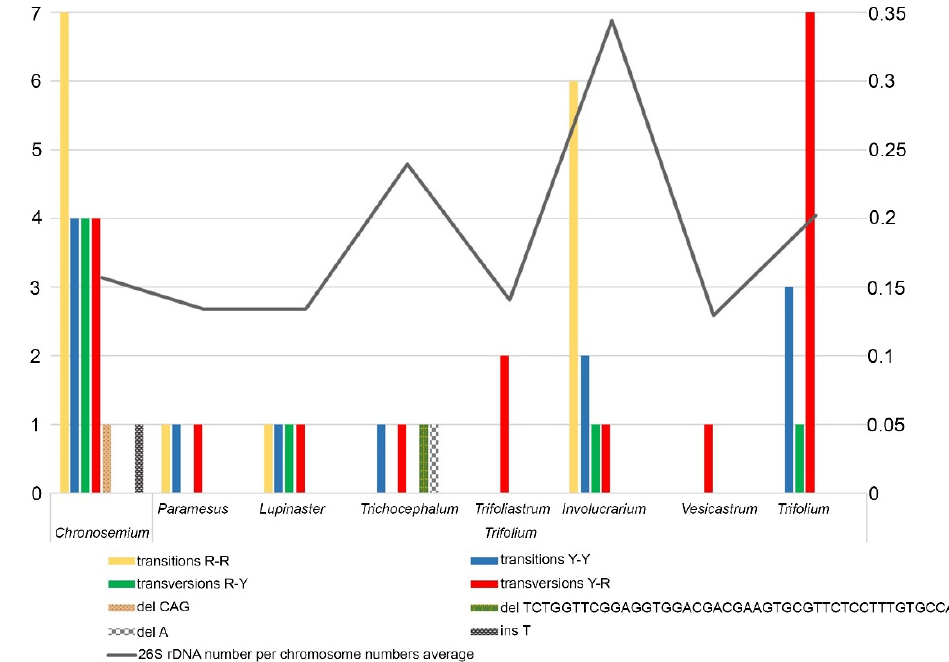
Figure 4. Number of substitutions, deletions, and insertions in ITS1 sequences for each Trifolium section (see also Table S3). Grey curve represents mean proportion of polymorphic loci per chromosome of the analysed species in individual sections.